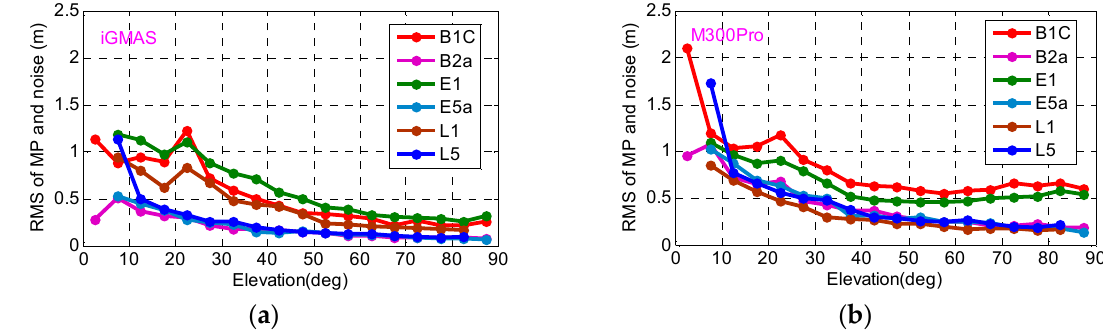
Figure 5. Root Mean Square (RMS) of multipath and noise error of the MP combination for BDS-3, GPS, and Galileo signals with the iGMAS ( a ) and M300Pro ( b ) receiver.